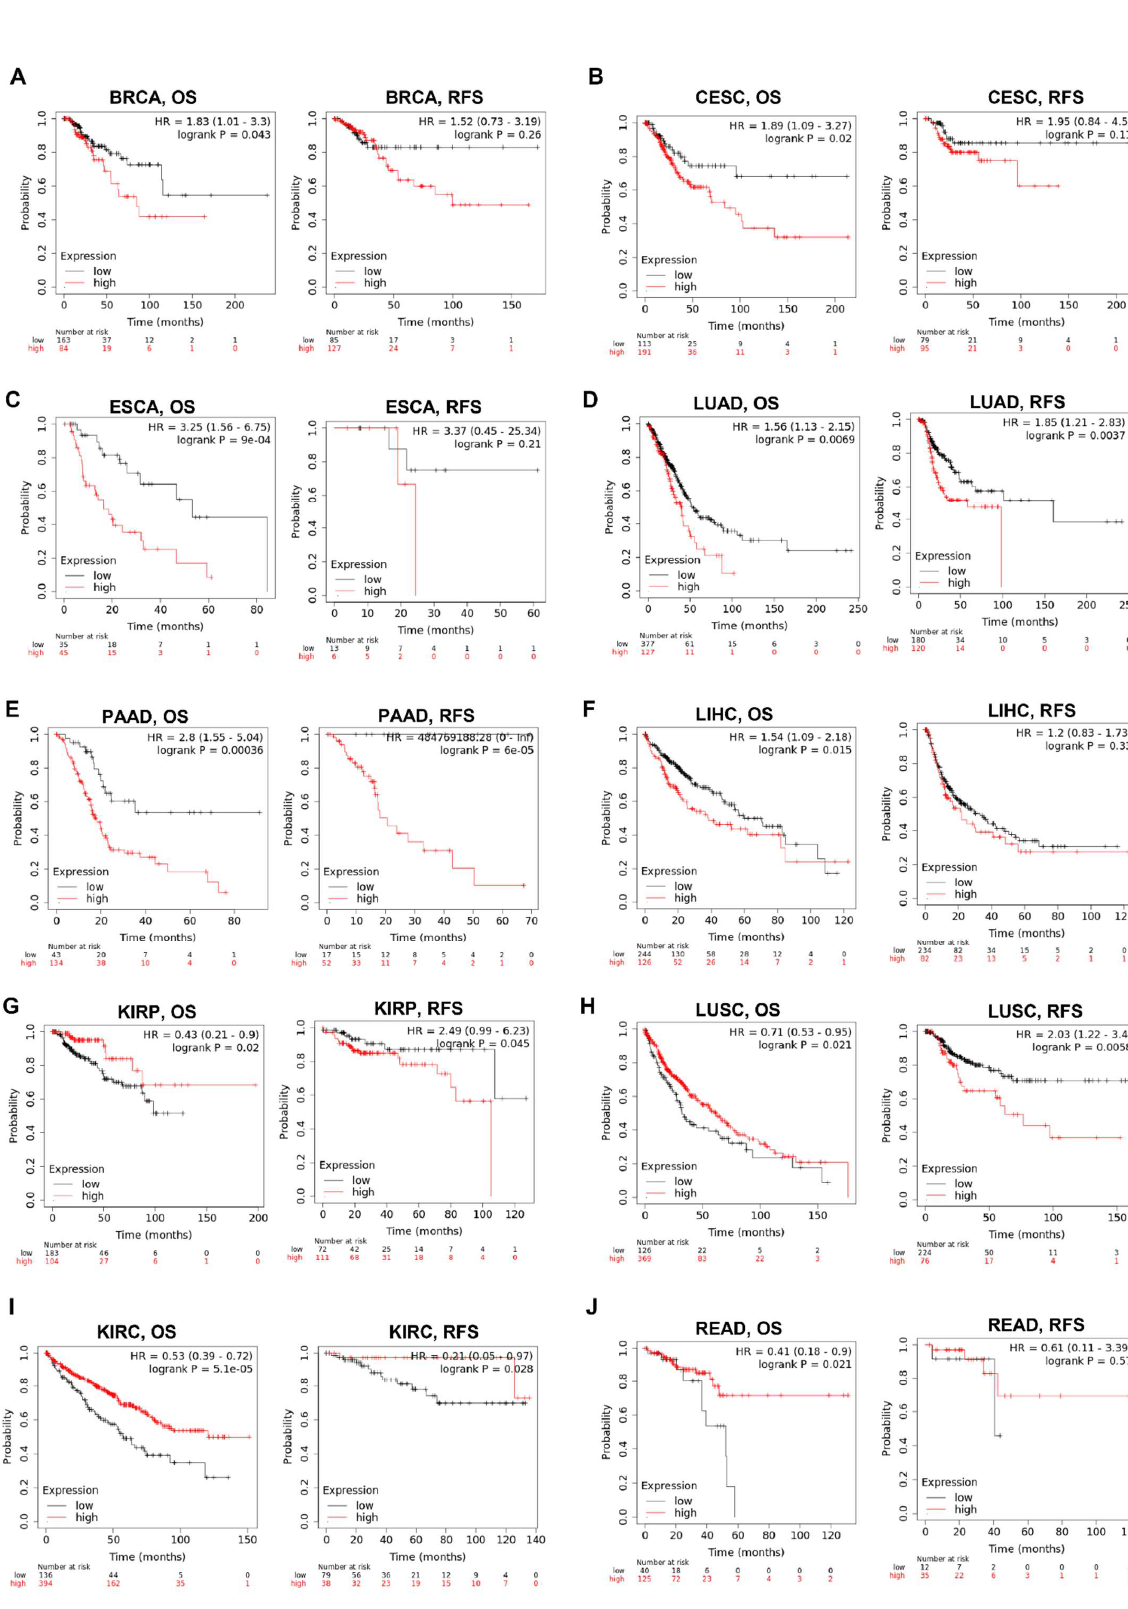
Figure 7. Kaplan–Meier survival curves comparing the high and low expression of KRAS in dif- ferent cancer types. OS and RFS of BRCA ( A ), CESC ( B ), ESCA ( C ), LUAD ( D ), PAAD ( E ), LIHC ( F ), KIRP ( G ), LUSC ( H ), KIRC ( I ), and READ ( J ). OS, overall survival; RFS, relapse-free survival. A p -value < 0.05 was considered a significant